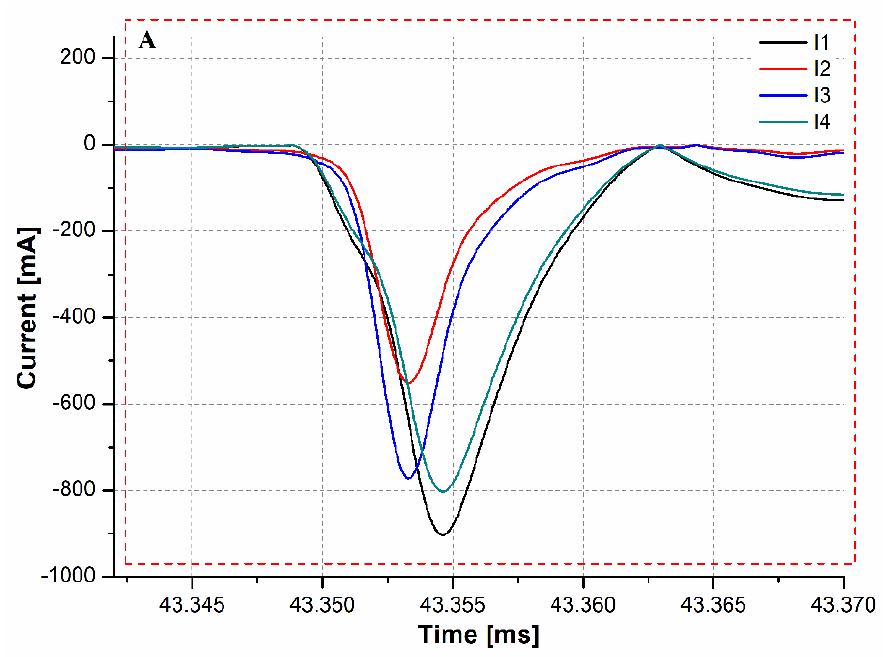
Figure 14. Current waveforms of R–C pulse generator (RCG)—zoomed-in view of one set of four pulses (I1, I2, I3, I4).